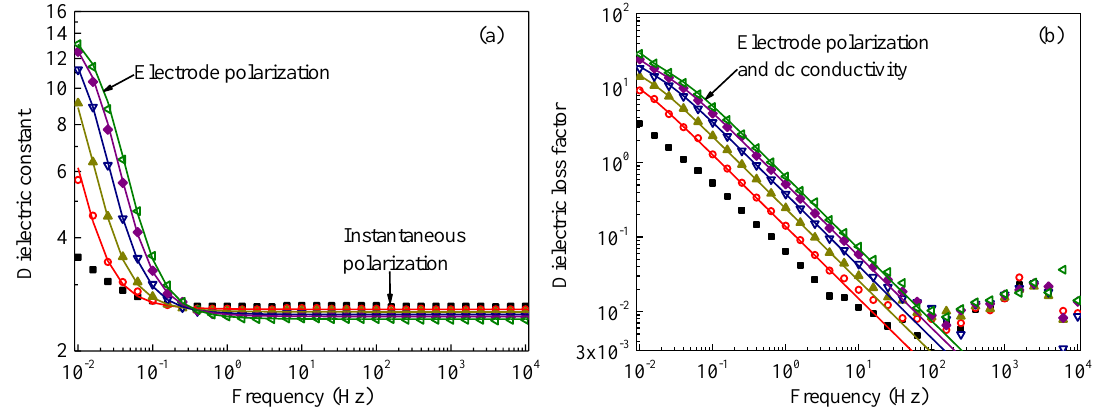
Figure 1. Dielectric constant r ′ ( a ) and dielectric loss factor r " ( b ) of unirradiated SiR, each as a function of frequency measured at various temperatures. Symbols and solid curves represent the data obtained experimentally and numerically, respectively. The measurements were conducted at 100 °C ( ), 120 °C ( ), 140 °C ( ), 160 °C ( ), 180 °C ( ), and 200 °C ( ).